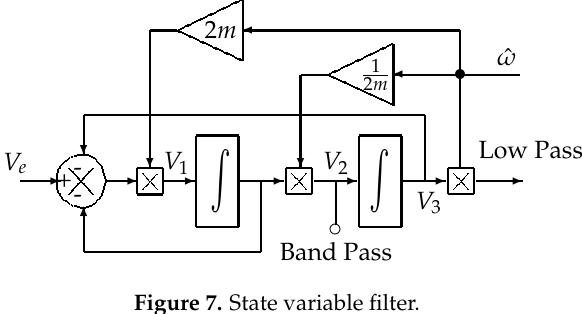
Figure 7. State variable